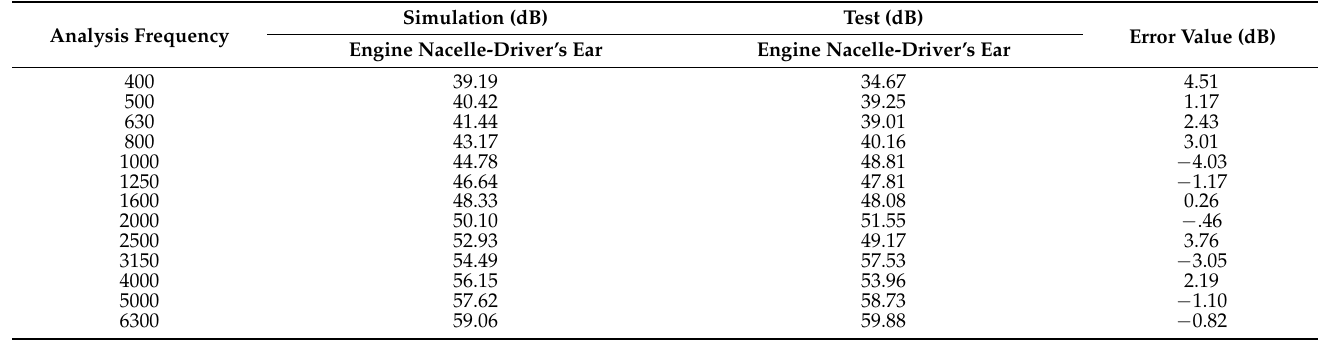
Table 6. Engine compartment excitation test